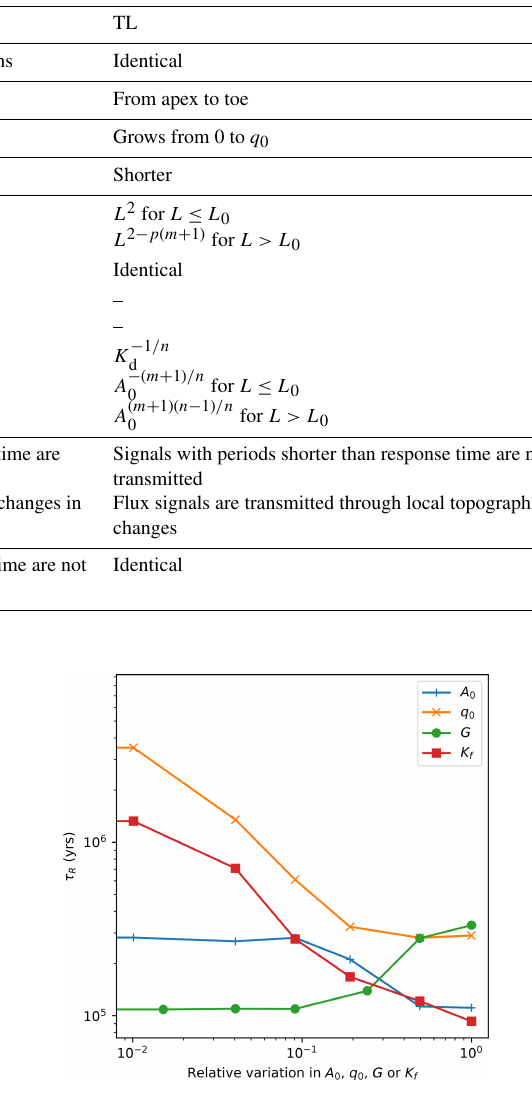
Figure 19. Residence time computed using Eq. 37 for the fol- lowing range of model parameters: A 0 ∈ [ 10 7 –10 9 ] m 2 , q 0 ∈ [ 10 4 – 10 6 ] m 3 yr − 1 , G ∈ [ 0 . 02–2 ] and K f ∈ [ 10 − 6 –10 − 4 ] , while using the mean value of the range for the model parameters as a refer-